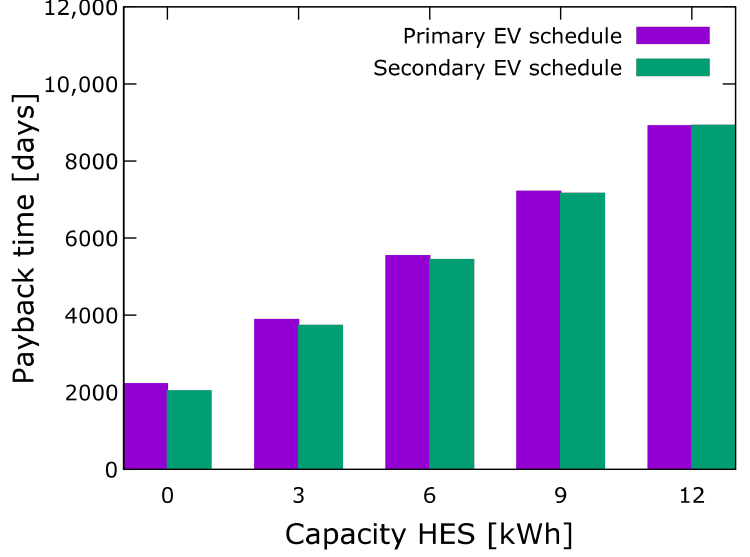
Figure 11. Payback time of the energy system, disregarding EV investment